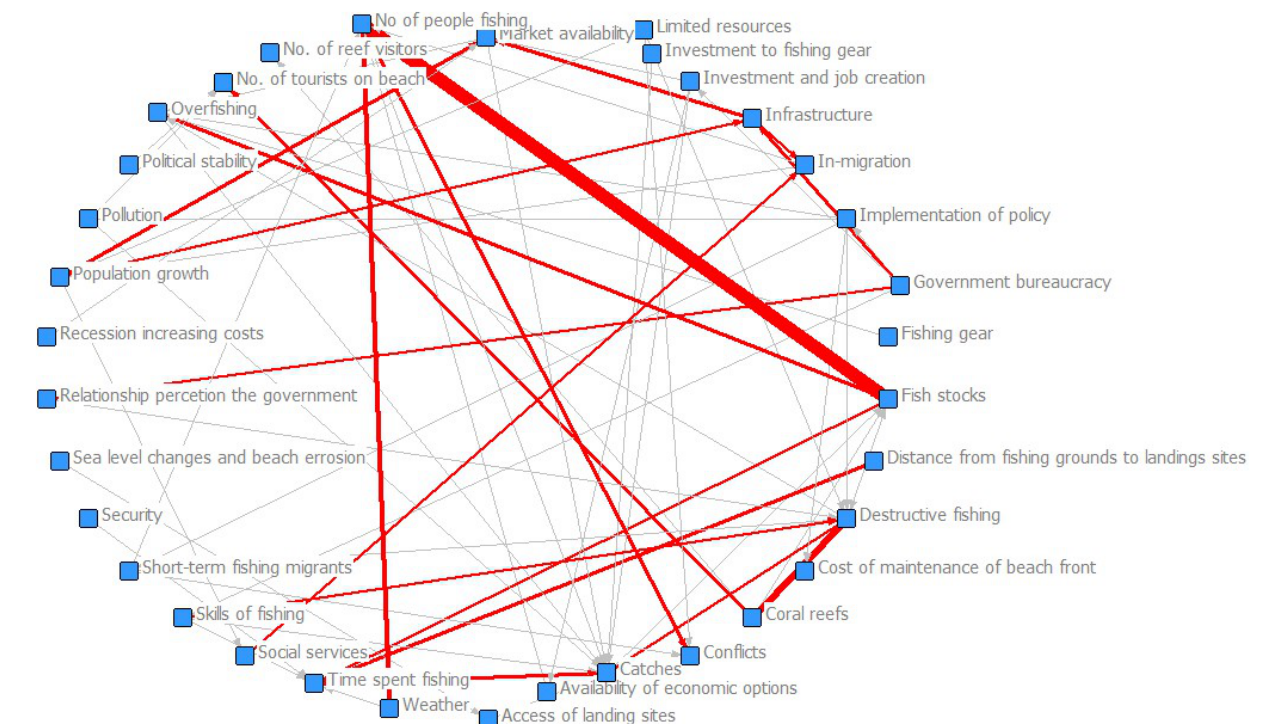
Figure S3. Collective model in a network representation. Links thickness represent degree of importance as identified by stakeholders.